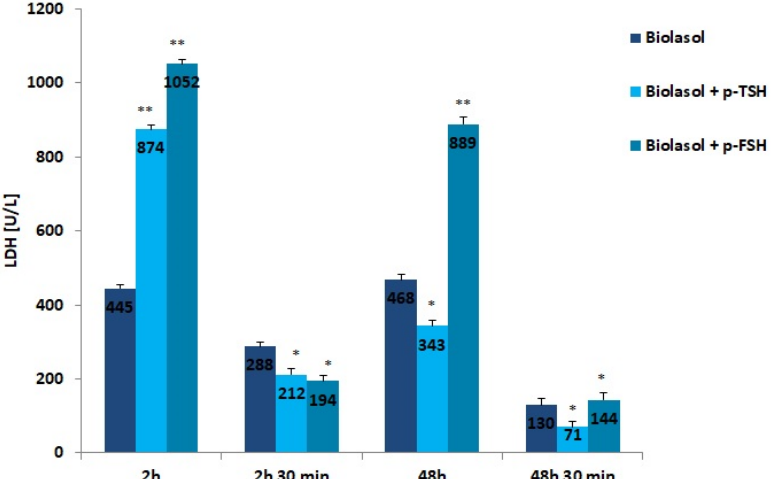
Figure 3. LDH activity in the collected perfusates. The values are expressed as mean ± SEM. * p < 0.05; ** p < 0.01 compared to the control group (Biolasol).